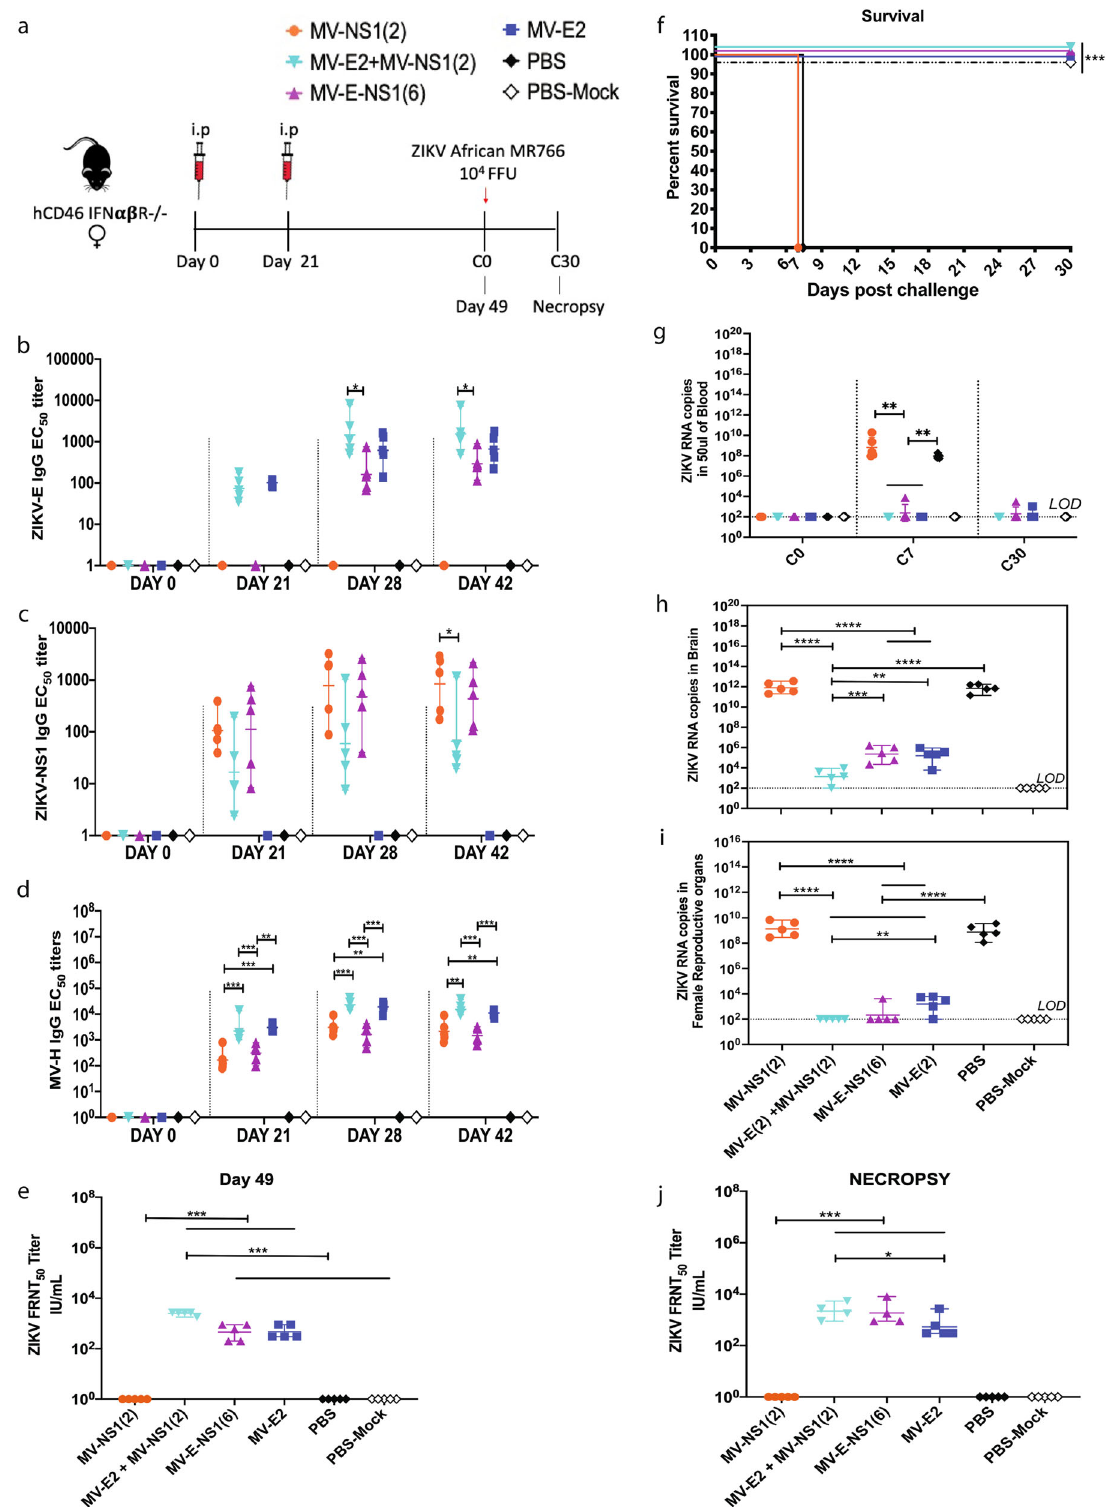
organs (Fig. 4h, i) of the MV-E2 and MV-E-NS1(6) mice than in the MV-NS1(2) mice and the PBS mice that were euthanized when they showed signs of ZIKV disease. The combination group had signi fi cantly lower viral RNA in the brains and complete viral clearance in the female reproductive organs than the MV-E2 Published in partnership with the Sealy Institute for Vaccine